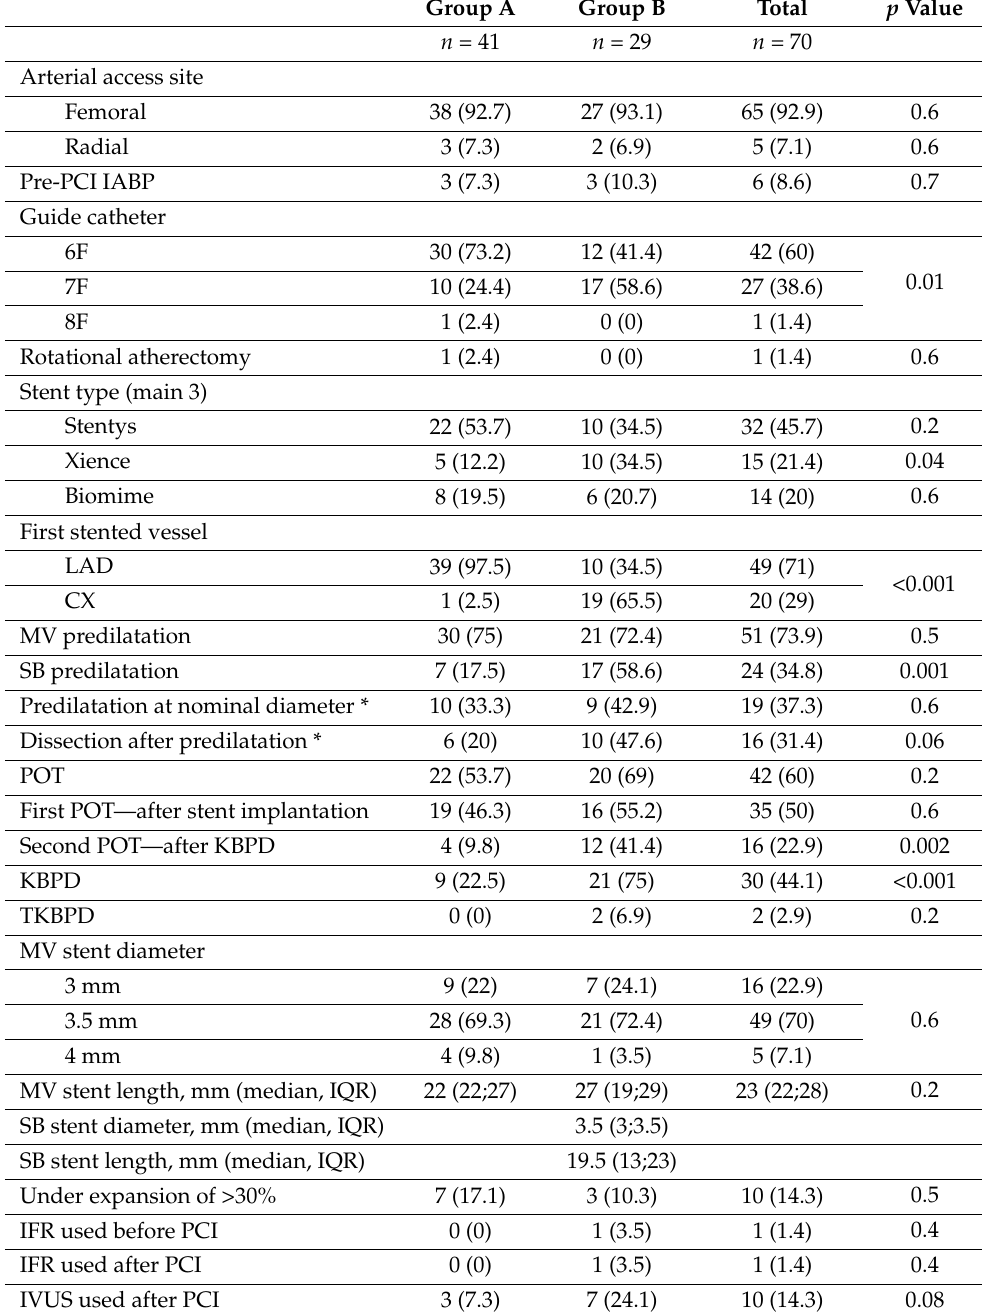
Table 3. Procedural characteristics according to the stent strategy in patients with unprotected left main coronary artery disease and acute coronary syndrome (Group A—one stent strategy; Group B—two stent